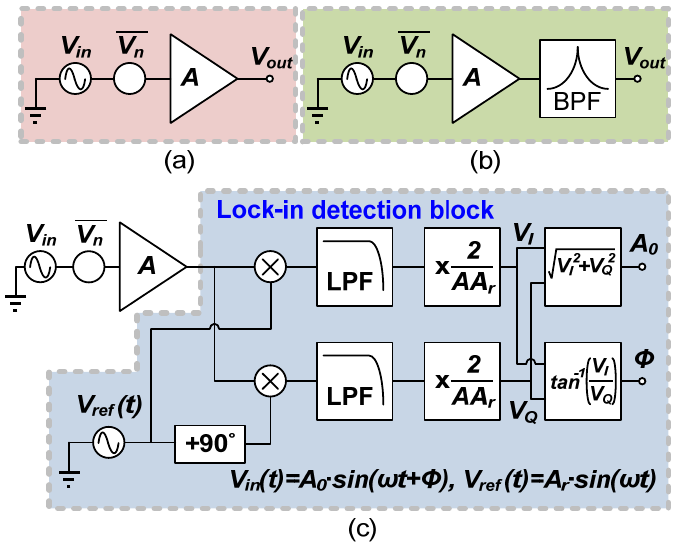
Figure 1. Simple measurement system of V in with ( a ) only an amplifier, ( b ) an amplifier with a bandpass filter, and ( c ) an amplifier and lock-in detection block.